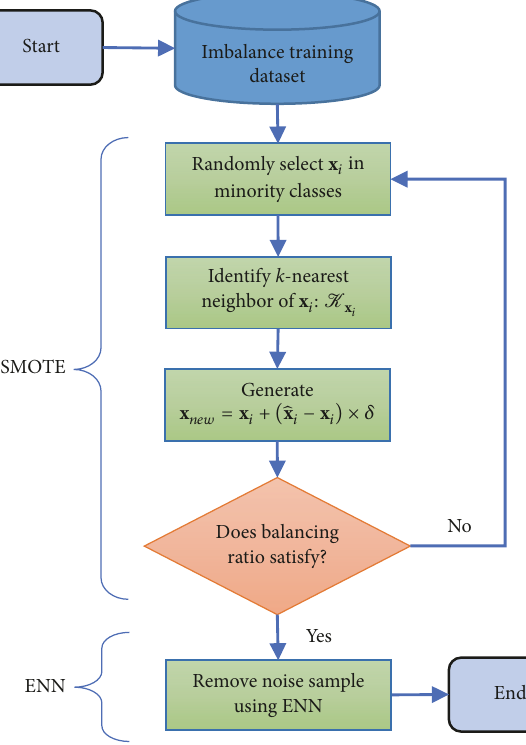
Figure 4: The flowchart of SMOTE-ENN